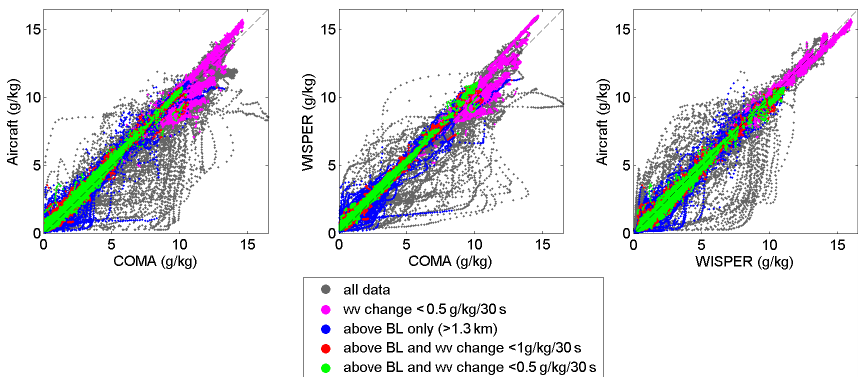
Figure 2. Comparison of water vapor specific humidity q from the three instruments for ORACLES-2016, for all flight data and for subsets based on altitude or change in water vapor with altitude. This subsetting highlights that the majority of the disagreement between instruments (grey dots) is within the planetary boundary layer and/or during aircraft ascents/descents through rapidly changing conditions.